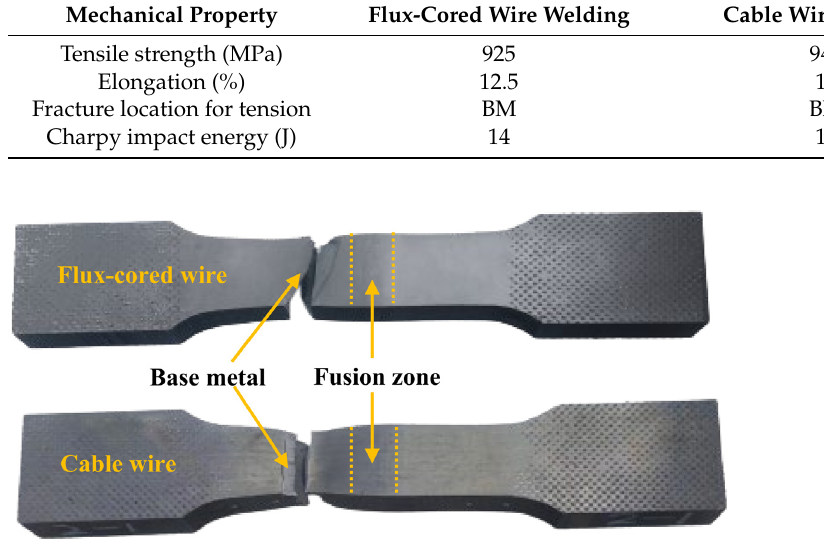
Table 3. Mechanical properties of the welding joints.